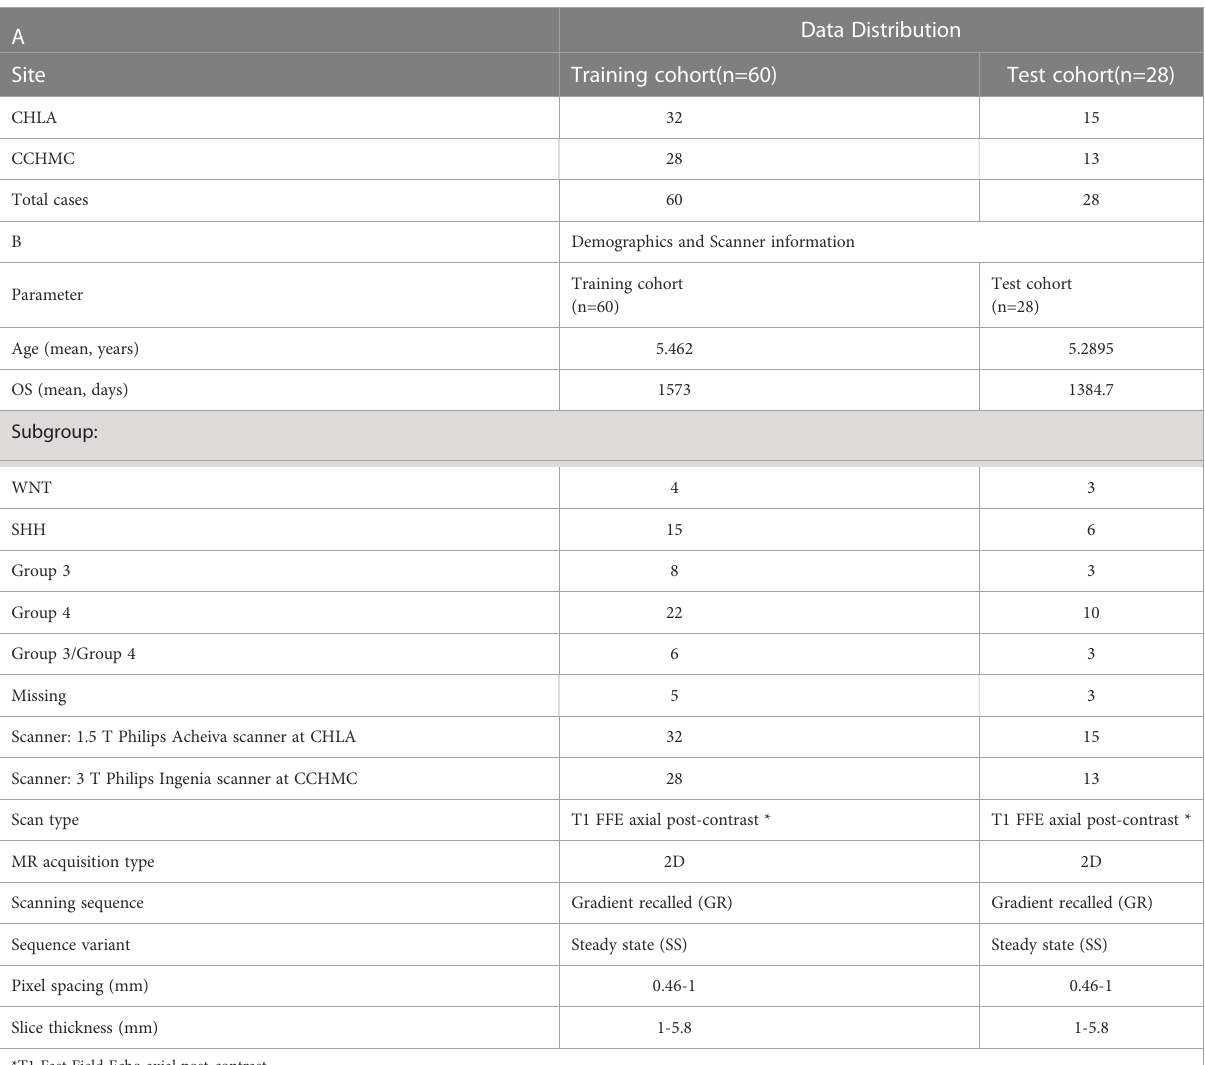
TABLE 1 (A) Data distribution across training and test cohorts. (B) Patient demographics (age, subgroup, and survival information) as well as scanner